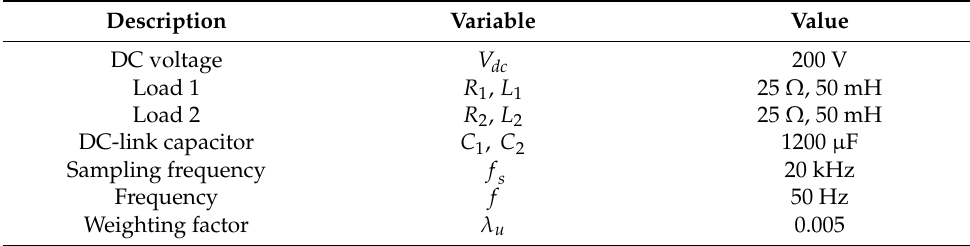
Figure 8. Simulation diagram of the improved MPC algorithm for asymmetric T − type NPC inverter. Table 5. System parameters for simulation and